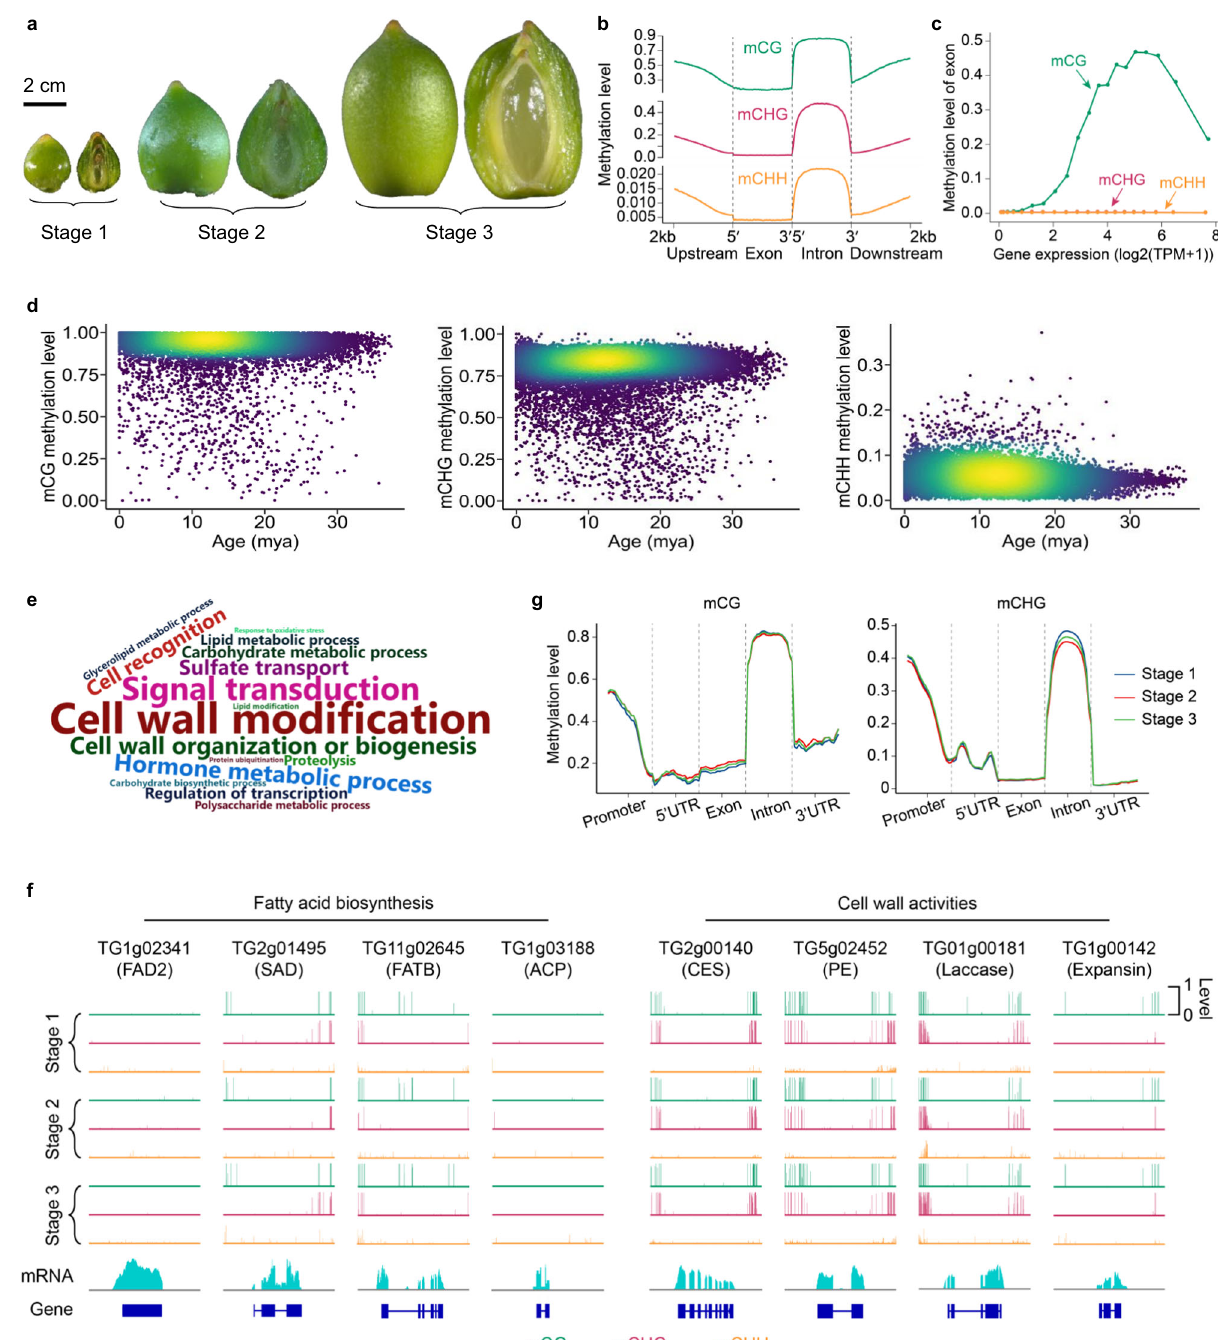
Fig. 5 | T. grandis seed methylomes. a Sampled seeds for methylome pro fi ling. Pictures show the outer side and inner side (through longitudinal section) of the seeds. b Methylation levels of exon, intron and gene fl anking regions in seeds. c Methylationlevelsatthreecytosinecontextsonexonicregionofgenes.Genesare categorizedinto20groupsbasedonorderedexpressionlevels.Foreachgroup,the median value of gene expression and the average methylation level across all exonicregions of genes arerecorded. d Methylation levels of intact LTR-RTsinthe T. grandis genome. e GO terms enriched in genes overlapping with demethylation